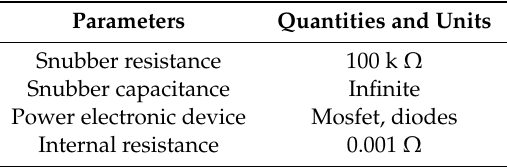
Table 5. Parameters of inverter.